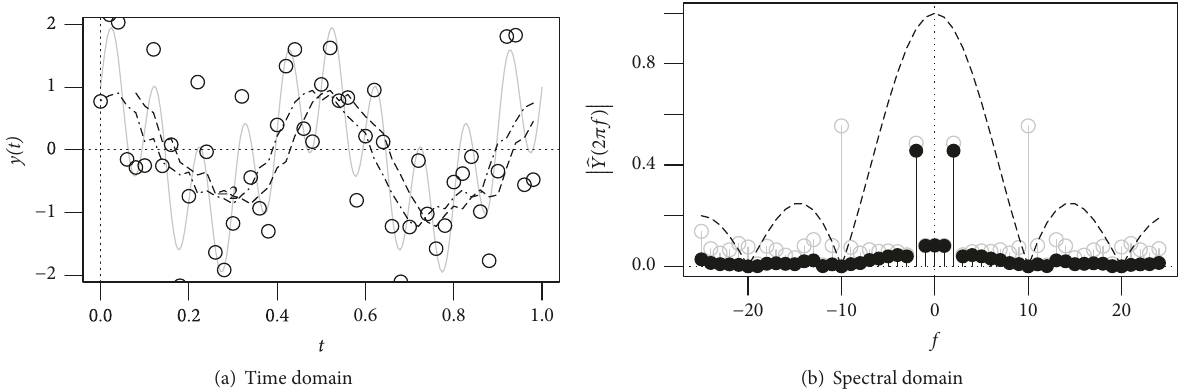
Figure 10: Calculating the moving average to reduce the noise and to reject the high frequency. Panel (a) shows the original function (gray line) and the noisy sampling points (open symbols). The result of the moving average in the time domain is given in (a) for the convolution (dashed) and the shifted FFT (dash-dotted). (b) displays the spectrum of the original function (gray), the filtered result (black), and the kernel function